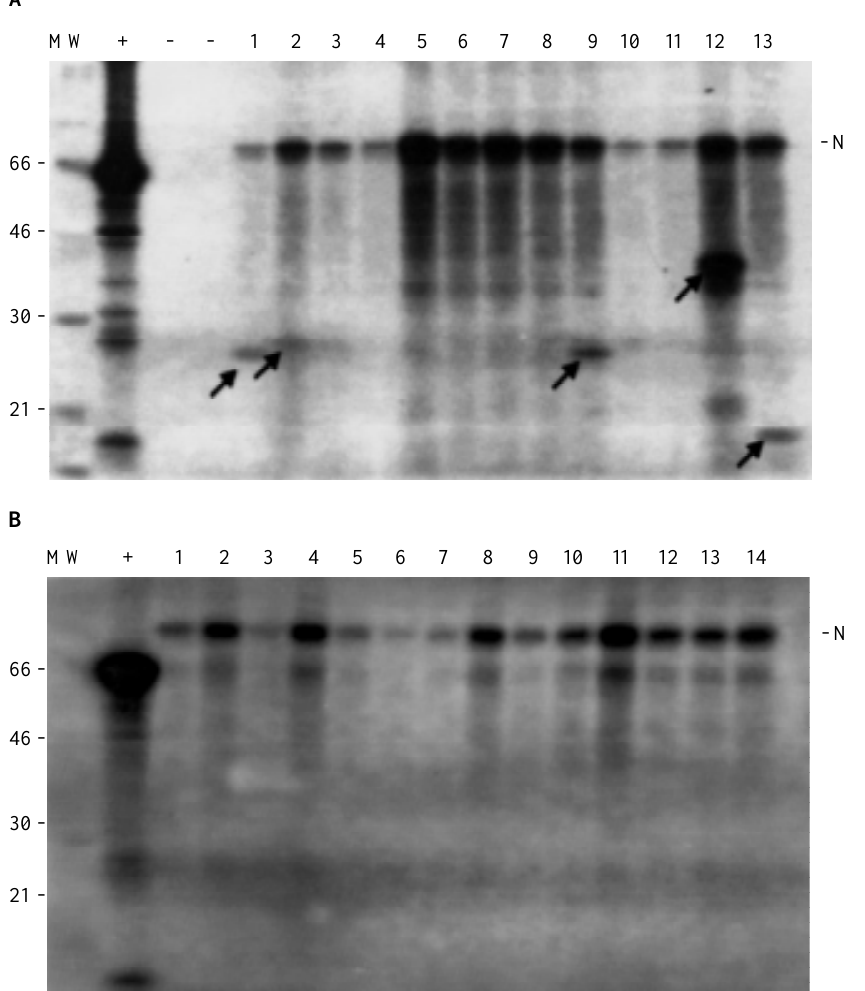
Figure 1 - Two overlapping segments of APC , encompassing codons 686 to 1217 and codons 1099 to 1693, were analyzed in 35 colon adenocarcinomas and 39 gastric adenocarcinomas. The figure shows the result of 13 and 14 representative samples of each tumor type obtained with the codon 1099 to 1693 fragment. A . Representative results obtained using DNA from colon tumors (1 to 13). Truncated protein products are indicated by the arrowheads. N indicates the position of the full length product. + and - are positive (luciferase) and negative (no DNA) controls, respectively. The numbers on the left are the size of the molecular weight (MW) markers. B . Representative results obtained using DNA from gastric tumors (1 to 14). N indicates the position of the full length product. + is the positive (luciferase) control. The numbers on the left are the size of the molecular weight markers (MW).